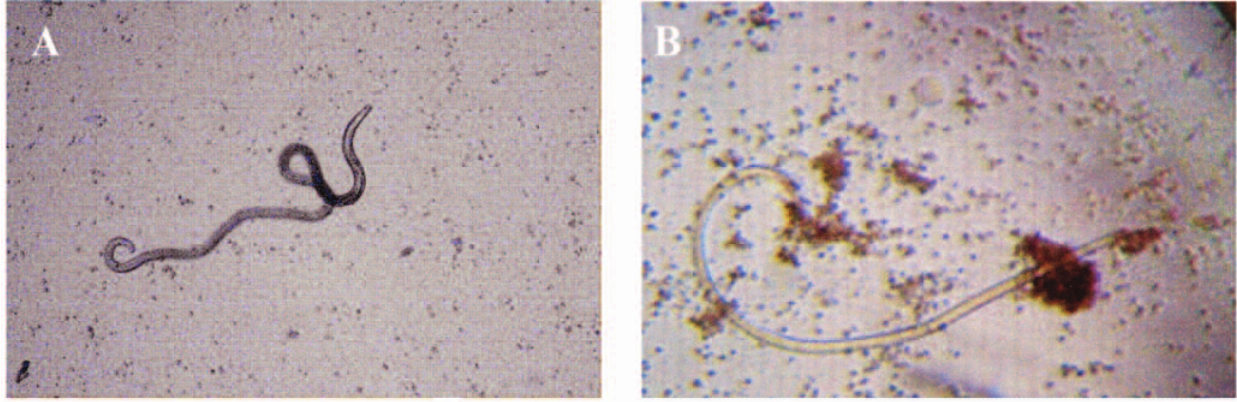
Figure 7. Photomicrograph of L3 recovered from cultures after ADCC assay. A. L3s incubated in NEN sera and PBMCs. There are no cells adhered to the larva and the larva was active. B. L3s incubated in EN sera and PBMCs. Note the cluster of cells adhered throughout the surface of larvae, but more specifically to the anterior and posterior end of the larva.